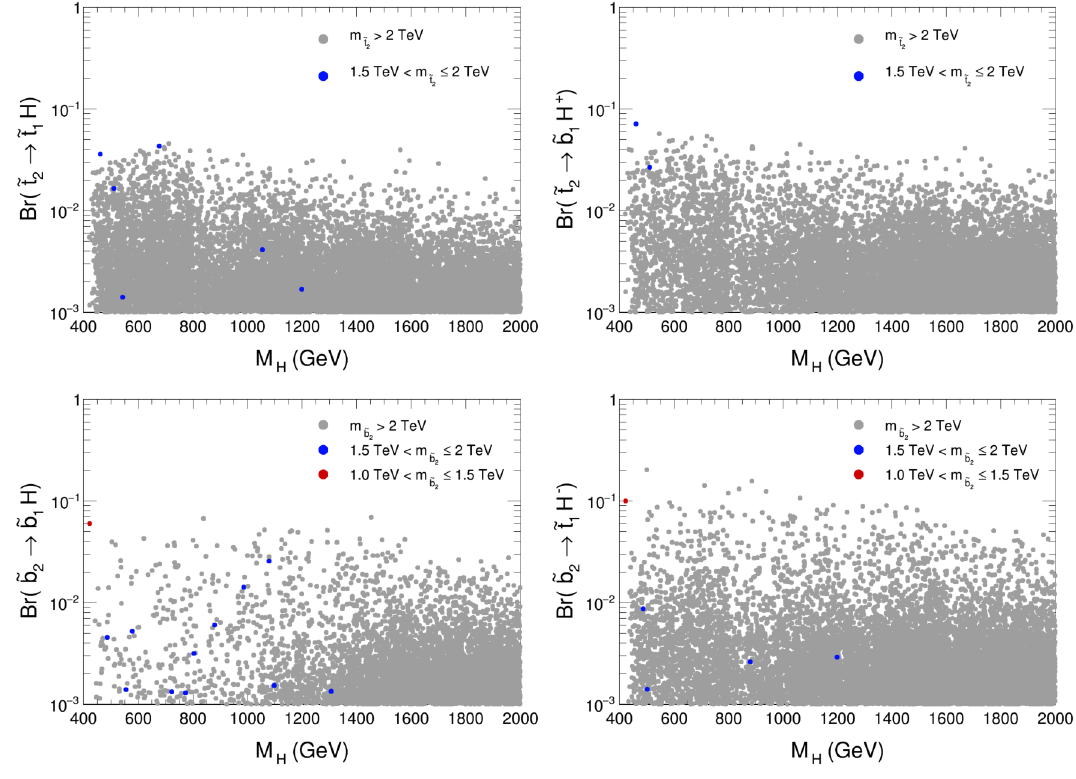
Figure 9. Branching ratios of heavy Higgs production from heavy squarks for all points passing phenomenological constraints. Points in grey are all points for which we find non-zero branching ratio to heavy Higgs final state, we highlight in blue points for which heavy stop/sbottom mass is less than 2 TeV.